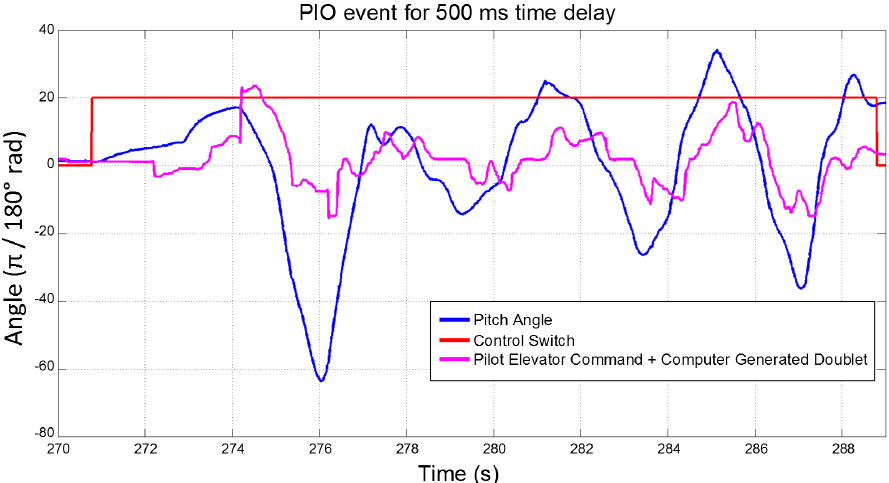
Figure 3. Pilot-Induced Oscillation (PIO) event following injection of 500 ms delay.